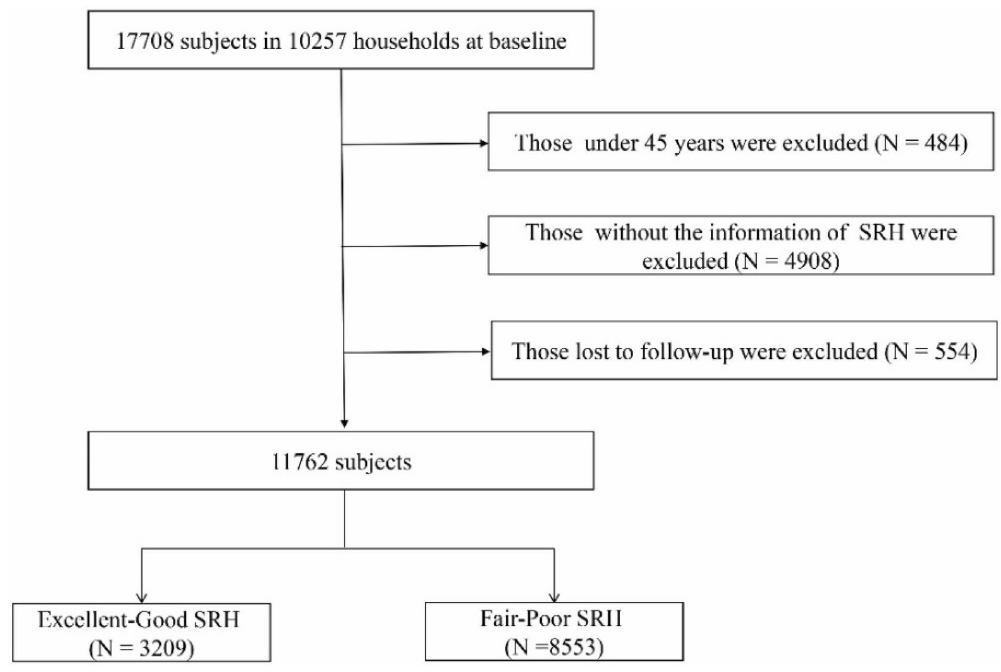
Figure 1. Flowchart of subject